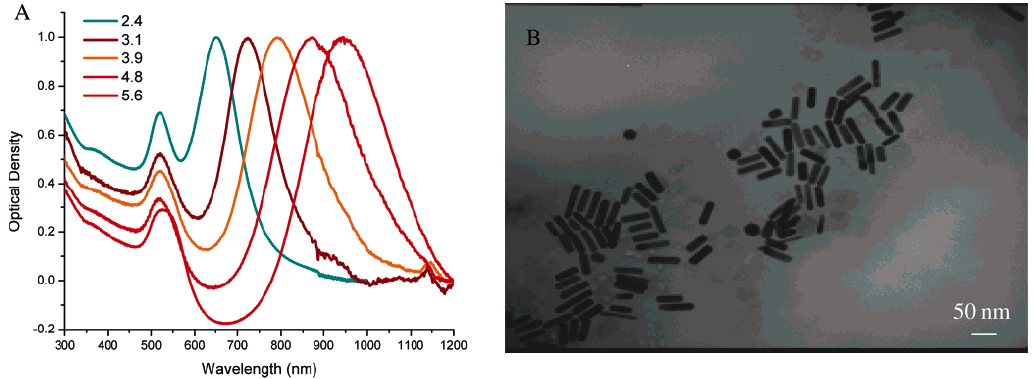
Figure 7. (A) Surface plasmon absorption spectra of gold nanorods of different aspect ratios; and (B) TEM image of nanorods of aspect ratio of 3.9. Reproduced with permission from [104] ® 2006, American Chemical